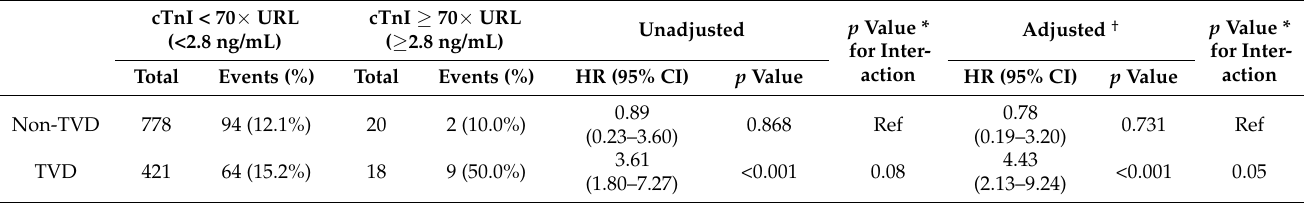
Table 3. Effect modification of TVD on the predictive value of cTnI for 5-year MACE.